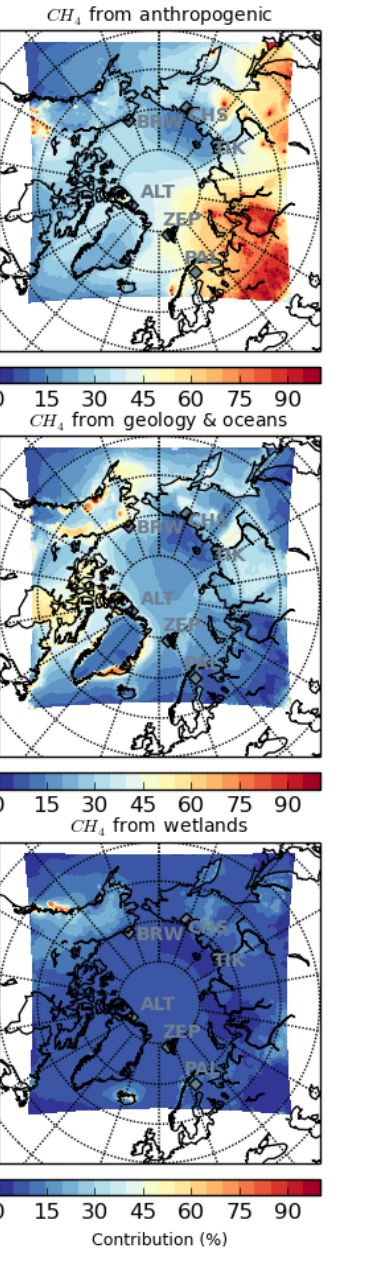
Figure 3. Mean source contributions (in %) to the CH 4 abundance (excluding CH 4 resulting from the boundary conditions) simulated by CHIMERE at 990hPa, over November–December and January–May